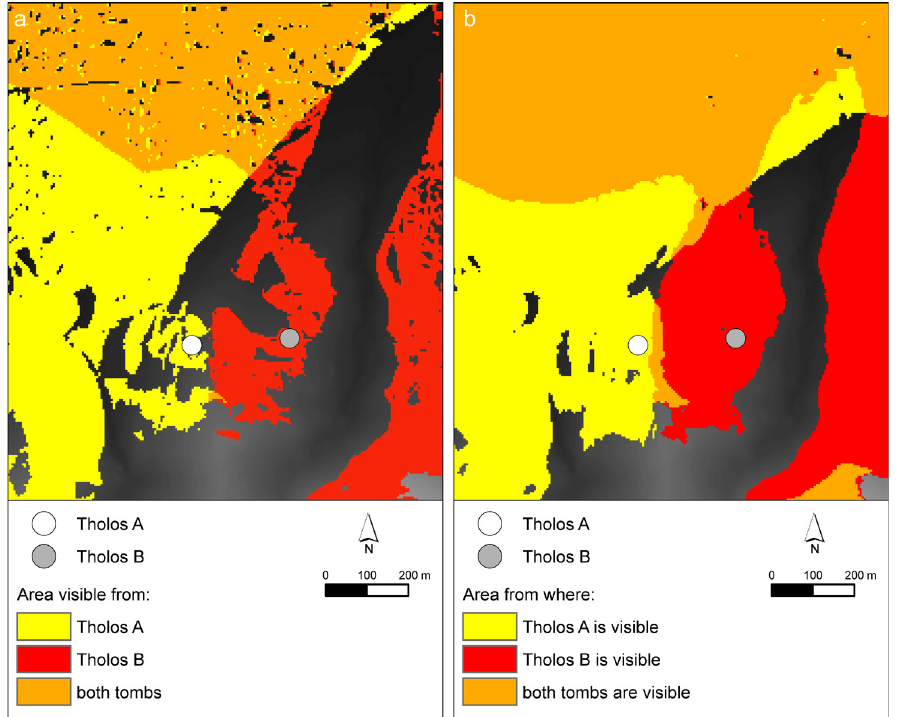
Figure 10. (a) View from Tholos A and Tholos B at Apesokari; (b) view of Tholos A and Tholos B at Apesokari, assuming the two tombs were 4.4 m and 5.1 m high,